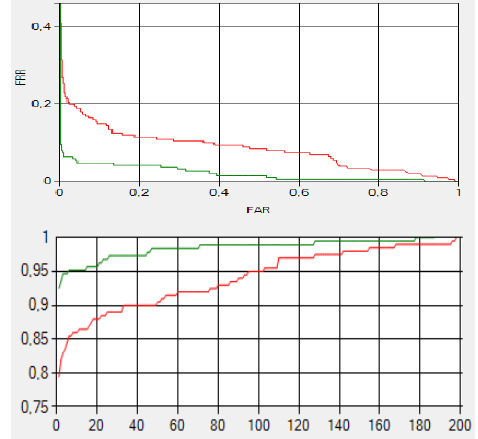
Figure 11. Face recognition results for test base FEI for non- frontal views: FAR/FRR (top) and CMC (bottom) graphs with (green) and without (red) face pose